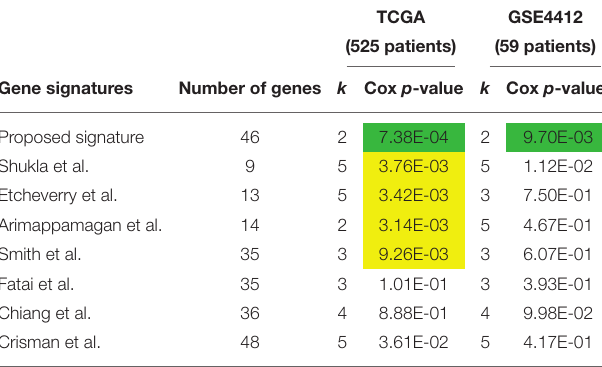
TABLE 1 | Prognostic performance of different gene signature panels related to GBM.